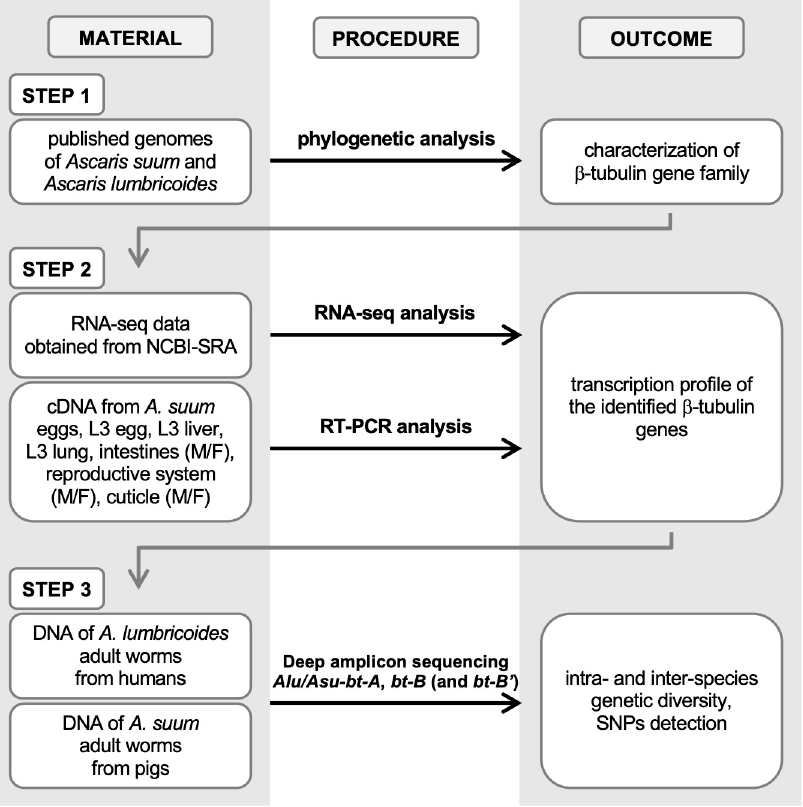
Fig 1. Schematic representation of the research workflow. RNA-Seq: RNA sequencing, NCBI-SRA: NCBI Sequence Read Archive, cDNA: complementary DNA, L3: third larval stage, M: male, F: female, RT-PCR: reverse transcription PCR, SNPs: single nucleotide